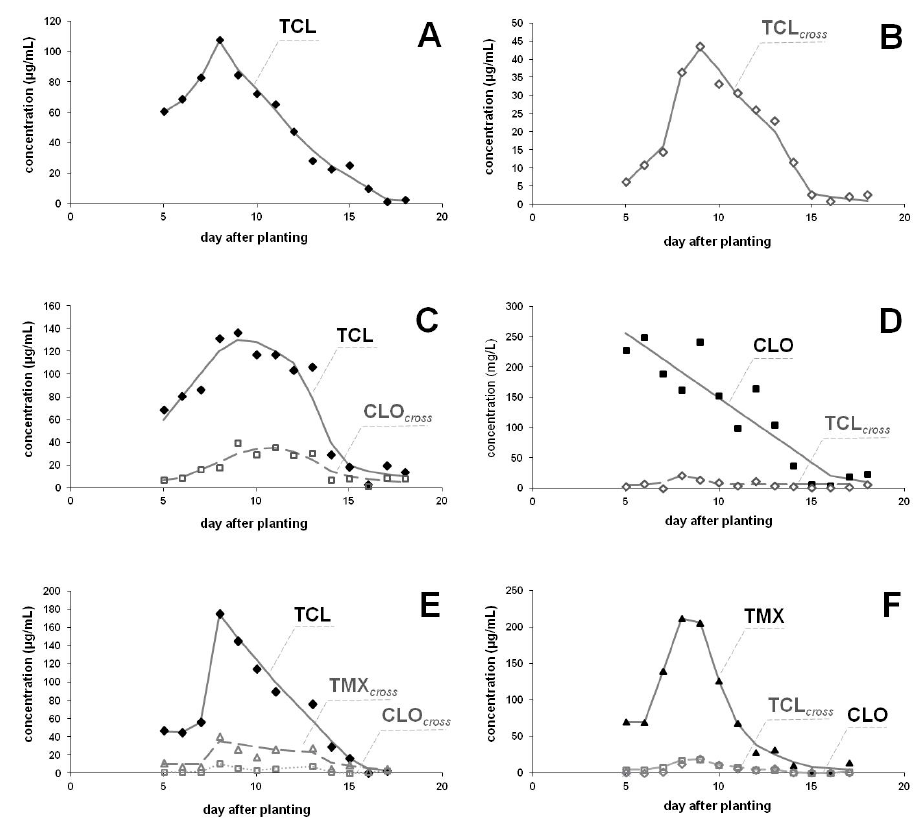
Figure 4. Neonicotinoid occurrence in the guttation liquid from own and neighboring seed coating in commercial (LG 30.369, O ccitan , D ekalb ) and landrace (Blue) maize varieties cultivated under semi-field conditions (sown in August). Seeds were coated with TCL ( A , C , E ) at 1.16 ± 0.18 mg / kernel concentration, non-coated ( B ), or coated with CLO ( D ) or TMX ( F ) at 1.22 mg or 0.61 mg per seed concentration, respectively. TCL in plants emerged from seeds coated with TCL ( ♦ ) or otherwise coated ( 3 ). CLO in plants emerged from seeds coated with CLO ( (cid:4) ) or otherwise coated ( (cid:3) ). TMX in plants emerged from seeds coated with TMX ( (cid:78) ) or otherwise coated ( ∆ ). Cross-contamination by coating neonocotinoids from neighboring seeds are indicated in grey color and term “cross”